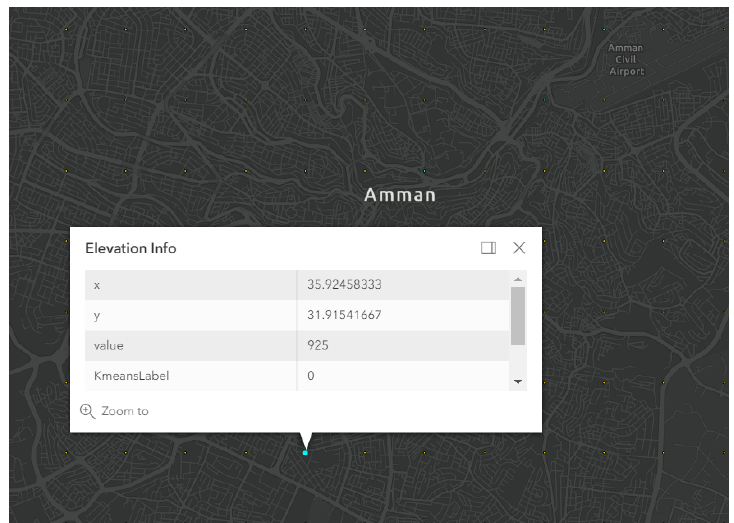
Figure 10. More details